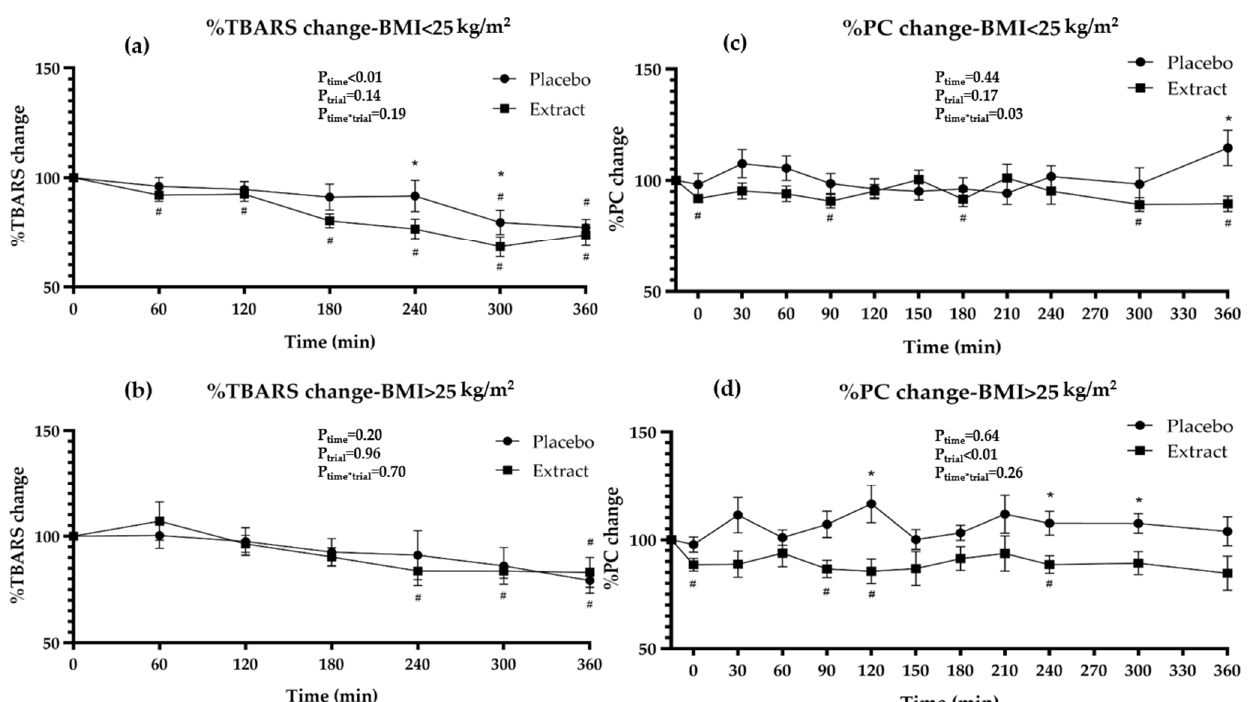
Figure 2. Percentage of change in oxidative biomarkers between interventions for ( a , c ) participants with BMI < 25 kg/m 2 , ( b , d ) participants with BMI > 25 kg/m 2 . Data are presented as means ± SEM. BMI, body mass index; TBARS, thiobarbituric acid reactive substances; PC, protein carbonyls. P time , P trial , P time*trial from RMANOVA. # p ≤ 0.05 compared to baseline values from paired samples t -test, * p ≤ 0.05 between interventions from Paired samples t -test.